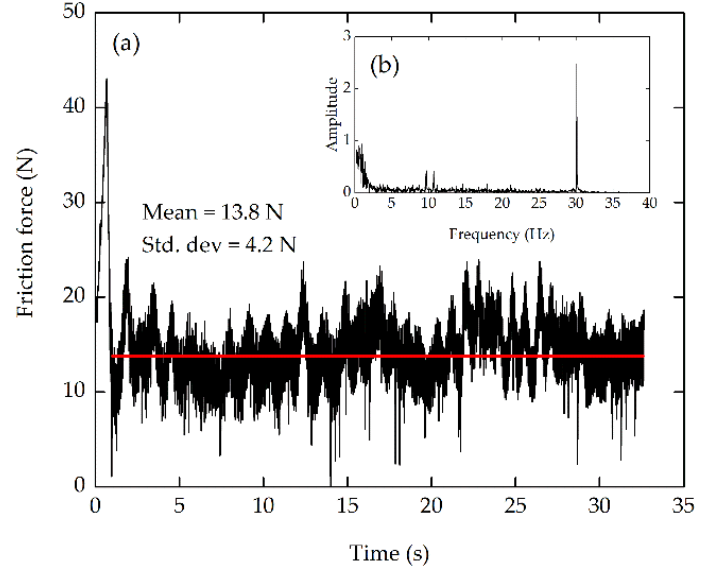
Figure 5. ( a ) Stick-slip friction regime on SS-Top at a velocity of 0.02 m·s −1 and a normal stress of 4.56 kPa. The mean value of the portion used in the calculation was 10.4 N (red line), and the standard deviation was 3.6 N; ( b ) Frequency of load oscillations in stick-slip motion.